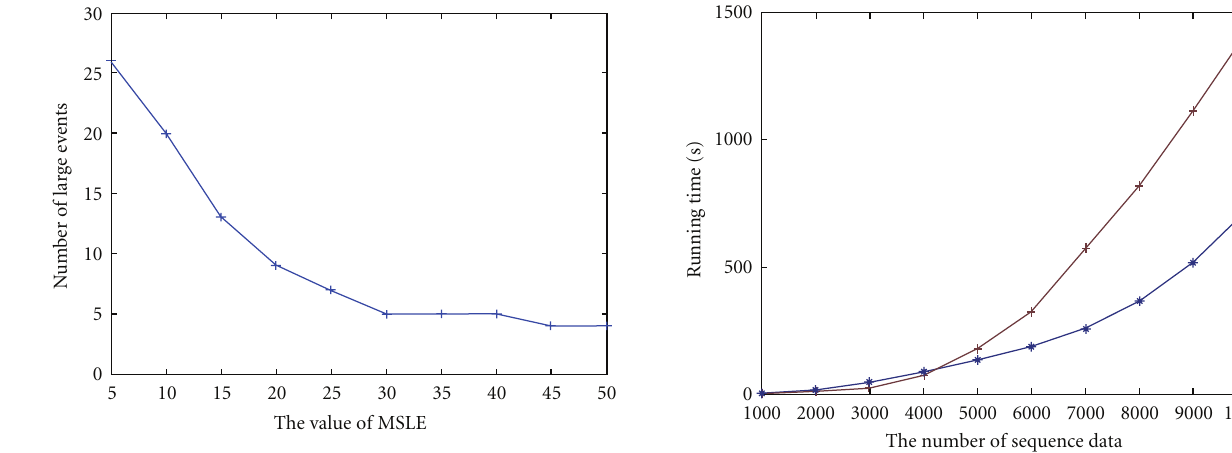
Figure 1: E ff ect of parameter in the process of getting large event set.